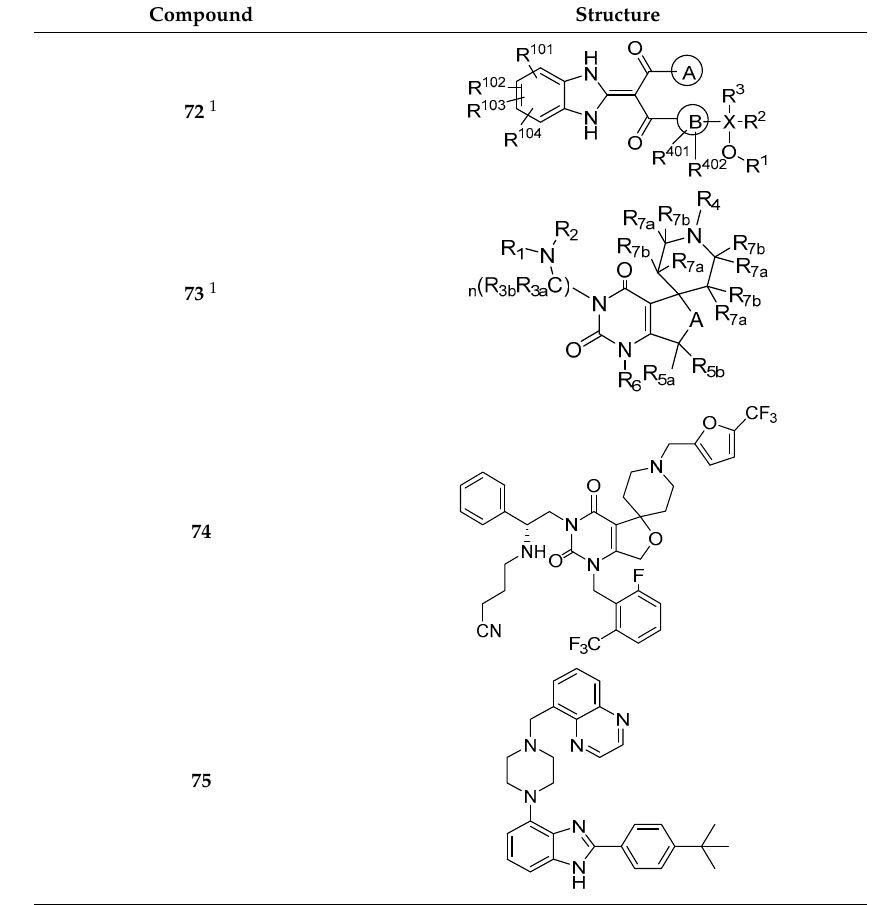
Table 13. Other GnRH antagonist Table 13. Other GnRH antagonist derivatives. Table 13. Other GnRH antagonist derivatives. Table 13. Other GnRH antagonist derivatives. Table 13. Other GnRH antagonist derivatives.